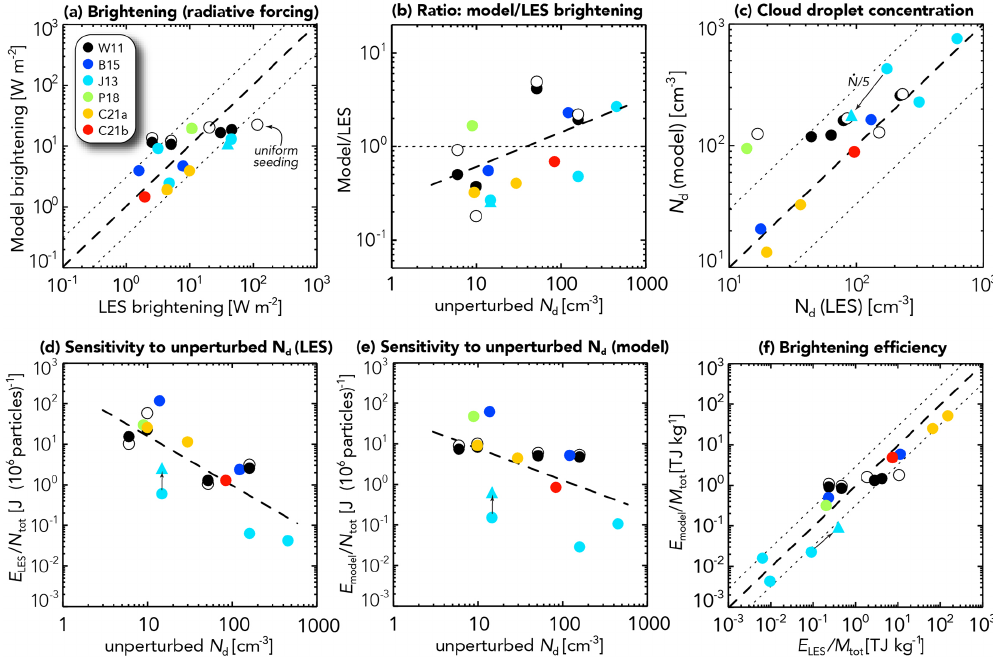
Figure 4. Comparison of heuristic model and LES results. Each color indicates a different study (see Table 2 for details). For W11, open circles indicate cases with uniform seeding across the domain. (a) Brightening (radiative forcing) for the LES and heuristic model. The dashed line indicates agreement, and dotted lines represent factor of 3 differences. (b) Ratio of the brightening in the heuristic model to that in the LESs plotted against the droplet concentration in the unperturbed case N d . The dashed line shows the linear least squares fit to the data. (c) Modeled vs. LES cloud droplet concentration, given the injection rates and particle size distribution employed in the model (see the text). The sensitivity of the normalized forcing (expressed as joules per injected particle) to the unperturbed N d for (d) the LES experiments is shown. (e) The heuristic model with lines representing least squares fits to the data. (f) The brightening efficiency expressed as the energy reflected over the course of the simulation experiments per mass of salt injected. For J13, the triangle indicates a reduced injection rate by a factor of 5, with the arrows connecting the simulation experiments with full and reduced injection